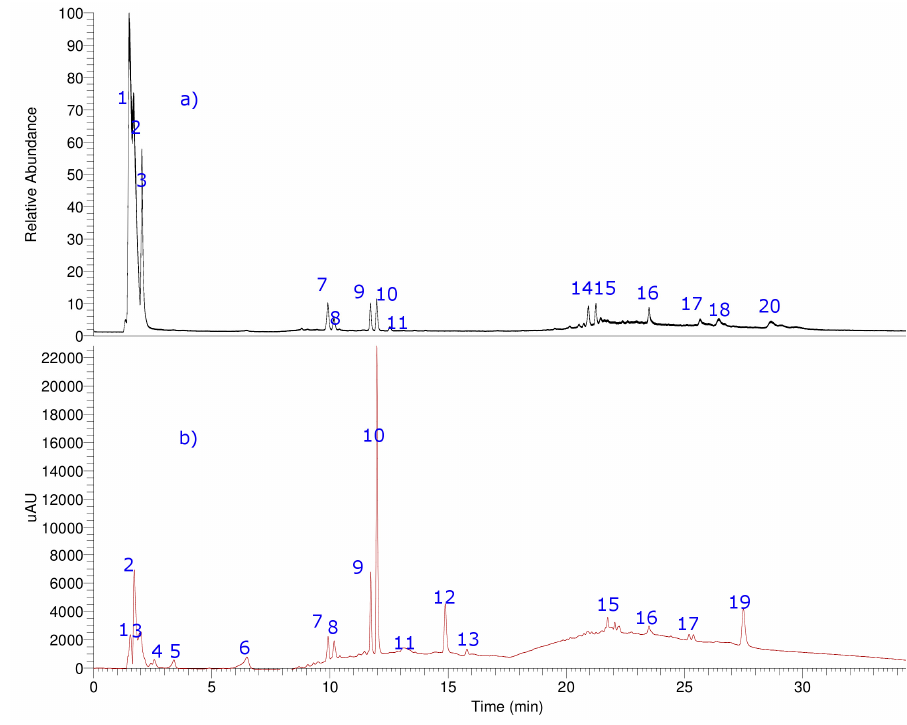
Figure 5. UHPLC chromatogram total ion current [total ion current ( a ), UV at 280 nm ( b )] of aqueous extract of M. bijugatus . The details of metabolites are in the Supplementary Material S1. Table 4. Identification of metabolites by UHPLC-PDA-OT-MS.